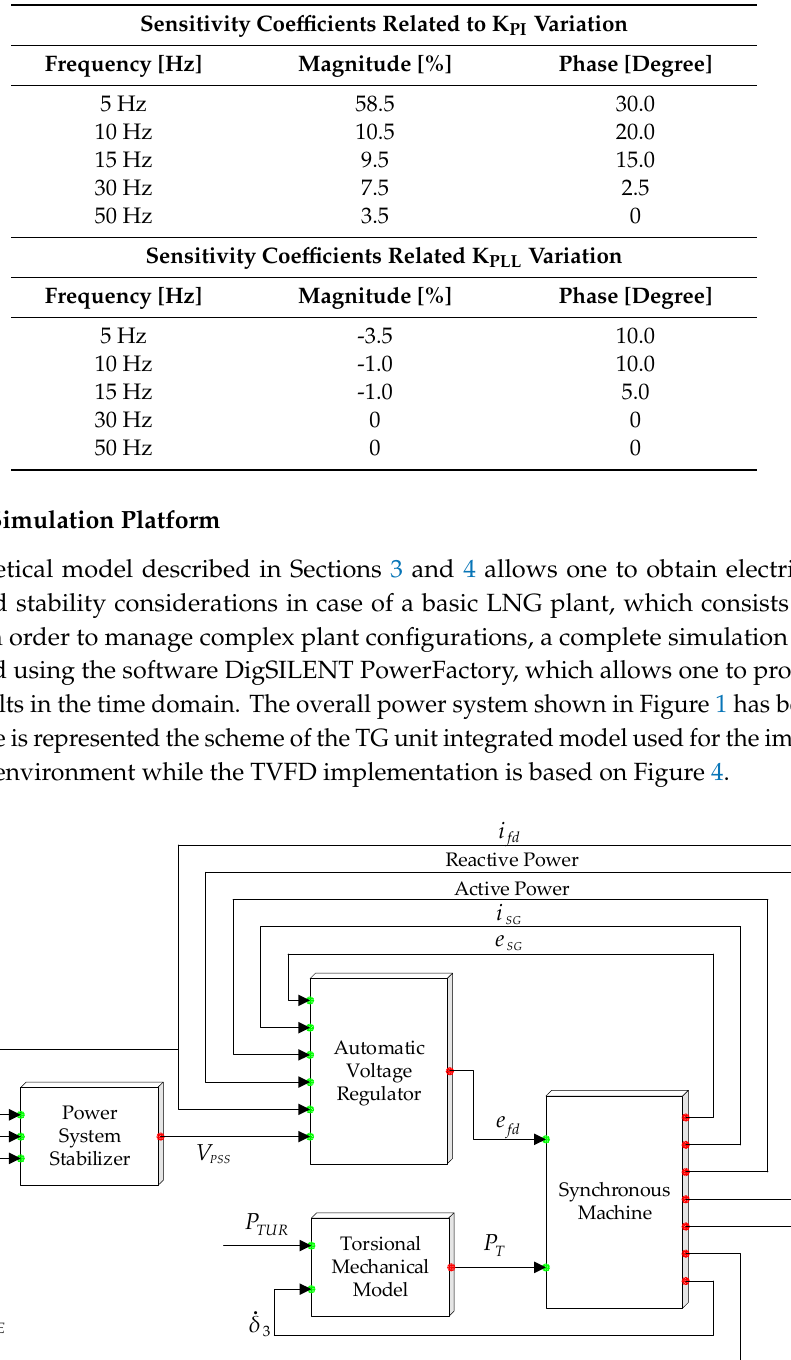
Table 7. TVFD controller’s sensitivity coe ffi cients.